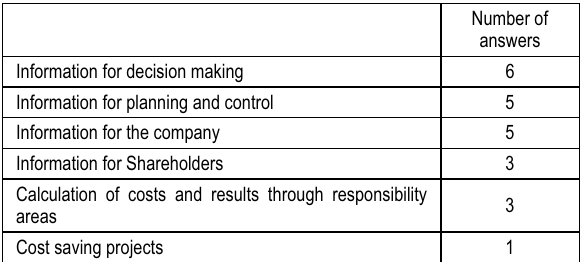
Table 5. Answer to the question: utility of management